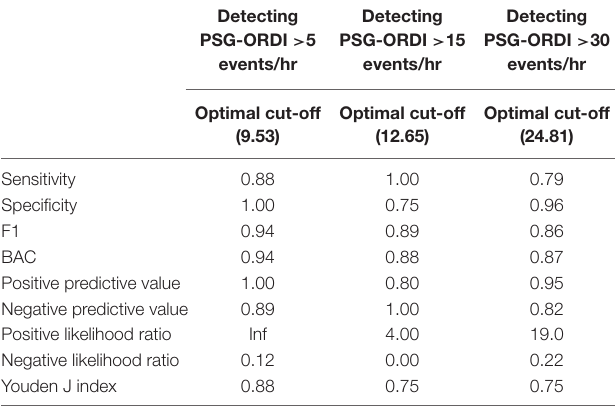
TABLE 1 | Diagnostic performance of MM-ORDI versus